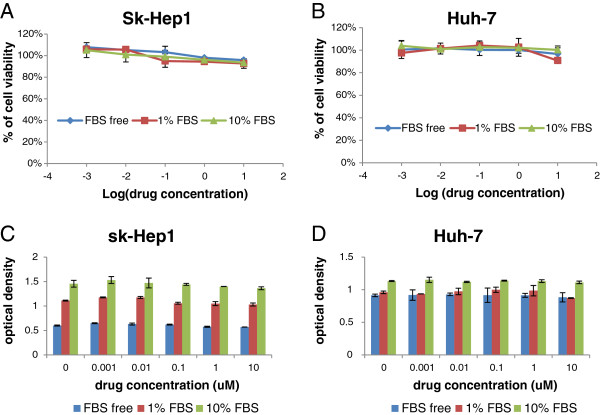
The comparison of cell viability with different treatment condition. Sk-Hep1 and Huh-7 cells were treated under three different conditions as described in methods. Results represented the mean (±SD) of three experiments. There was no influence of cell survival of sk-Hep1 (A) and Huh-7 (B) cells by dasatinib. Serum affected the cell concentration of sk-Hep1 (C) and Huh-7 (D) cells without the influence by dasatinib concentration.